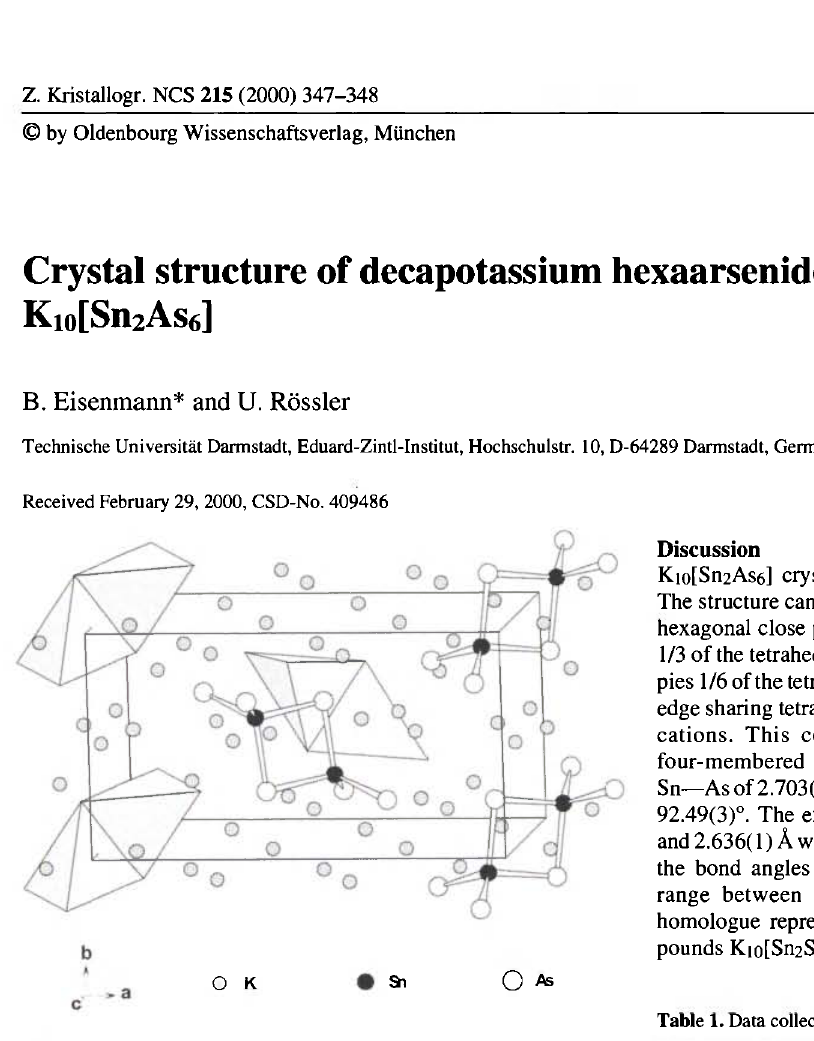
Table 1. Data collection and handling.